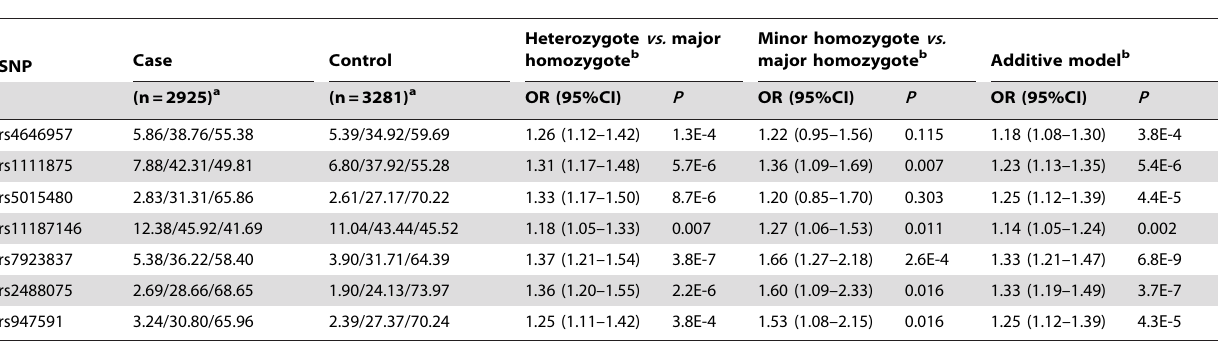
Table 3. Combined results for 7 SNPs consistently associated with type 2 diabetes risk in two stages.